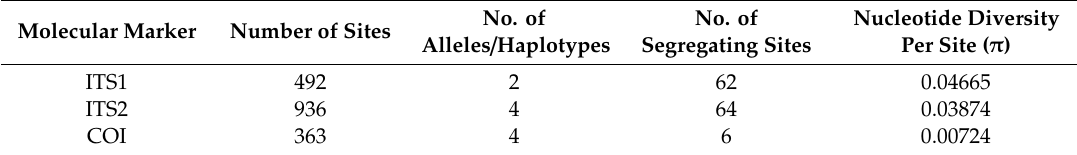
Table 2. Sequence diversity estimates for A. litchii.